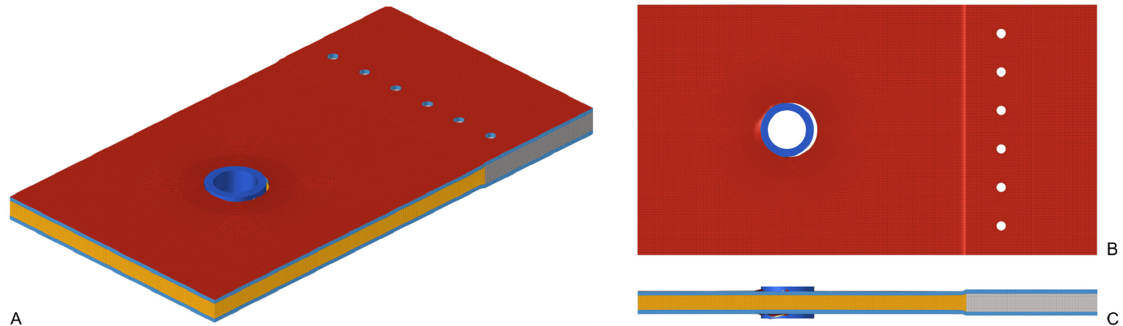
Figure 10. The numerical fracture surface of advanced composite joint model. ( A ) Fracture axonom- etry. ( B , C ) Fracture surface.